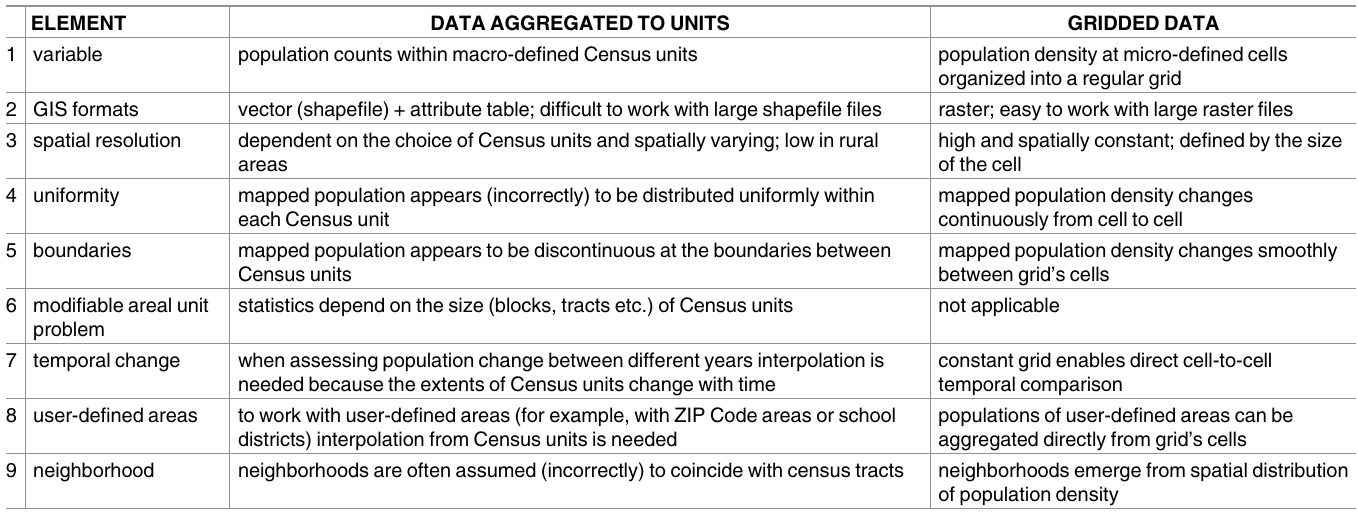
Table 1. Population data: Census units versus